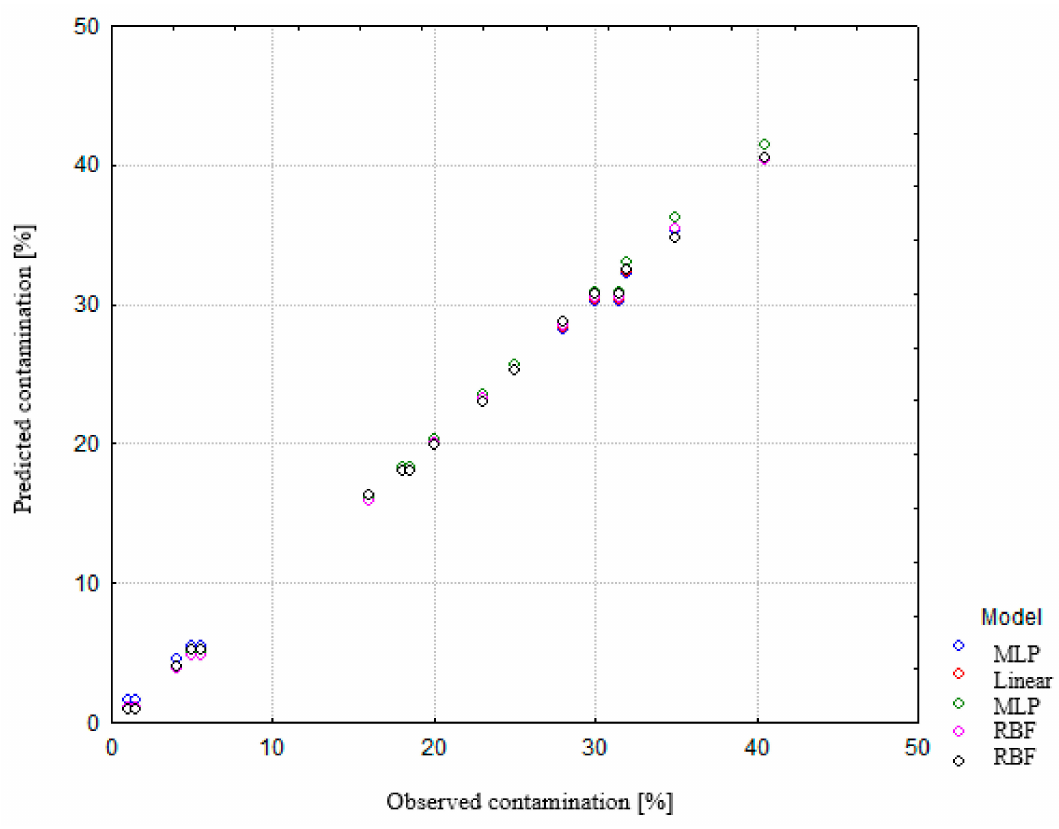
Figure 6. Fitting of models to predicted data [own